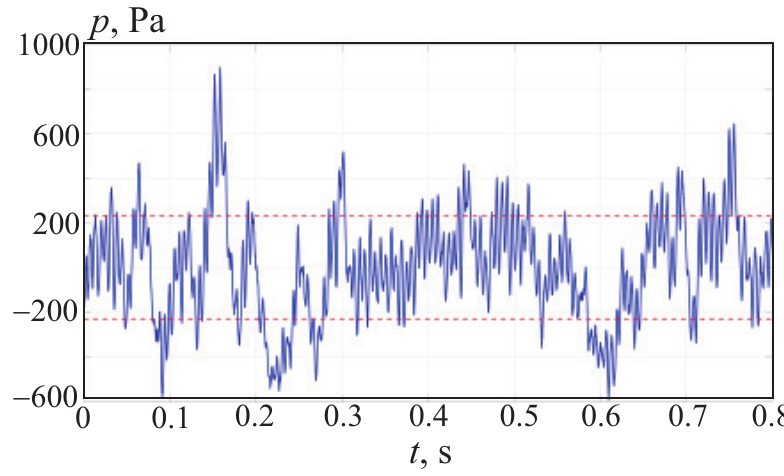
Figure 11. Time dependence of pressure on the wall at point ( 0.1,0,0 ) . The Fourier transform of the pressure signal at the same point is shown in Figure 12. Line 1 shows the results of calculations, line 2—smoothed spectrum, and columns—results